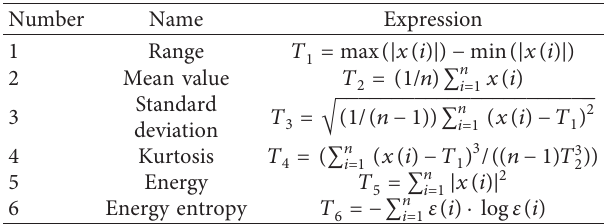
Table 4: Statistical